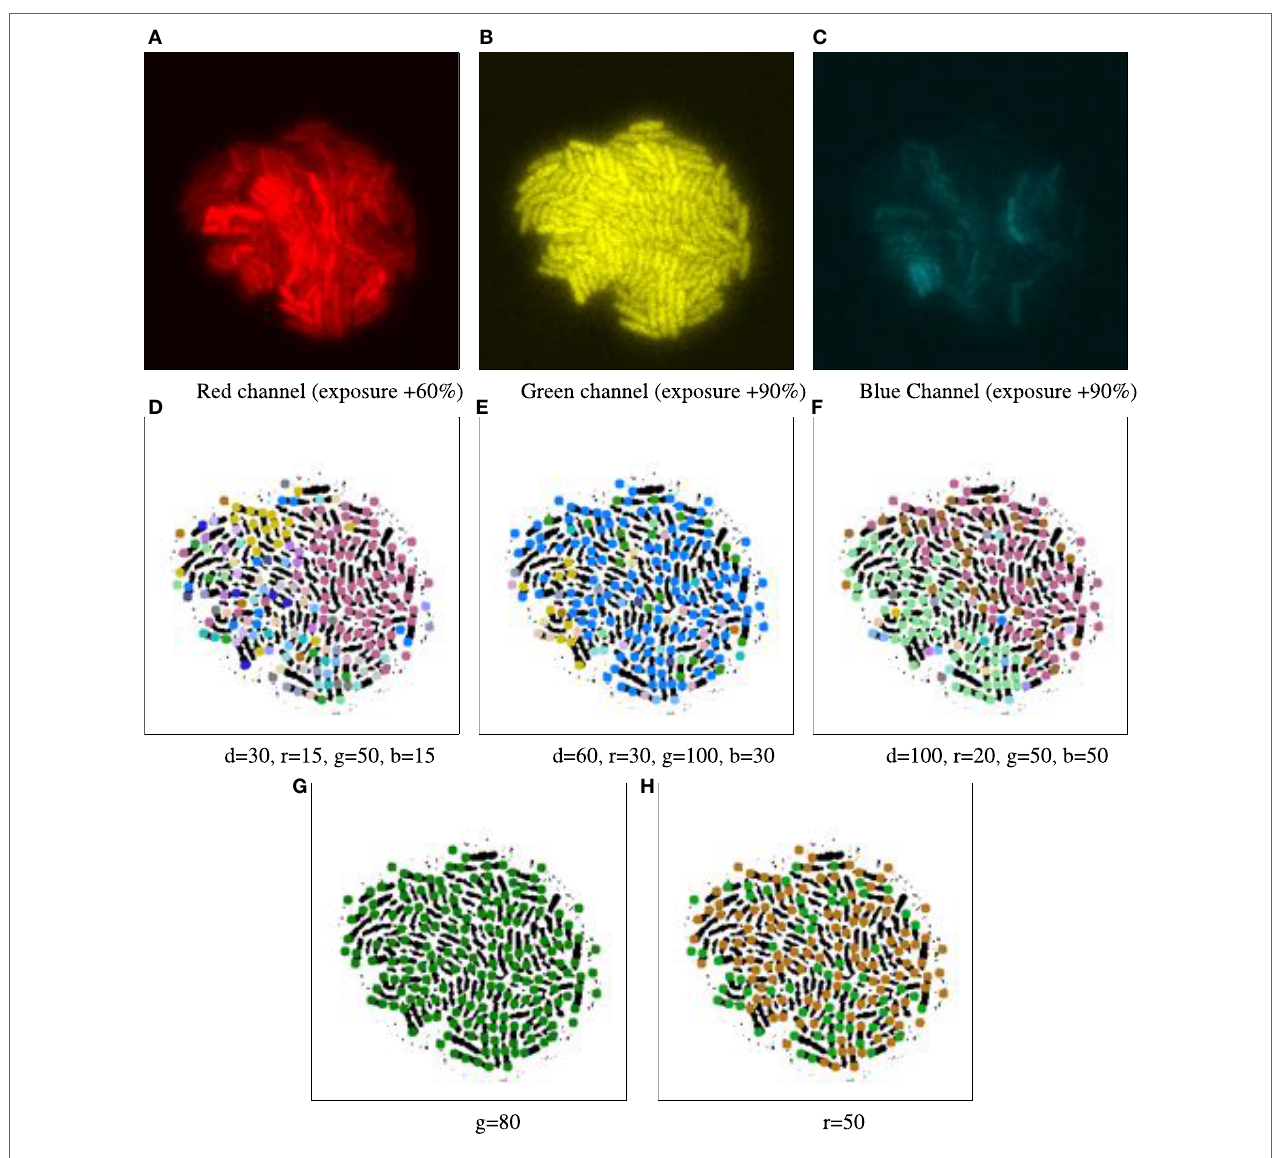
Figure 4 | Example of parameter tuning to emphasize different channels, for time point 16.5 h of biomovie D3. The binary images in the bottom row are annotated with 9-px dots showing particle locations, colored according to their patch IDs. The particle analysis thresholds in the previous computational step were set to 9 px particle diameter, a 5 px distance and 10-frame window for particle linking and a 3-frame window for time filtering. (a–c) Separate views of red, green, and blue channels show the high structural variation between each channel. (D–F) Three different combinations of settings yield patch structures that capture different combinations of channel features, with thresholds for geometrical distance (d), and channel specific differences in (r, g, and b). (g–h) Two examples of sensitivity analysis for individual channel thresholds (G: green, H: red), where the other channels are ignored by setting appropriate thresholds (thresholds are set to very high values: geometric distance values near the total image size, and color values near the maximum of 255). (g) The threshold of 80 for green depicts a homogeneous and constant signal across that channel, yielding a single main patch. (h) The threshold of 50 for red emphasizes the binary nature of that signal, yielding two major patches. In both (g) and (h) , the observed patches are exempt of spatial contiguity due to excluding the spatial